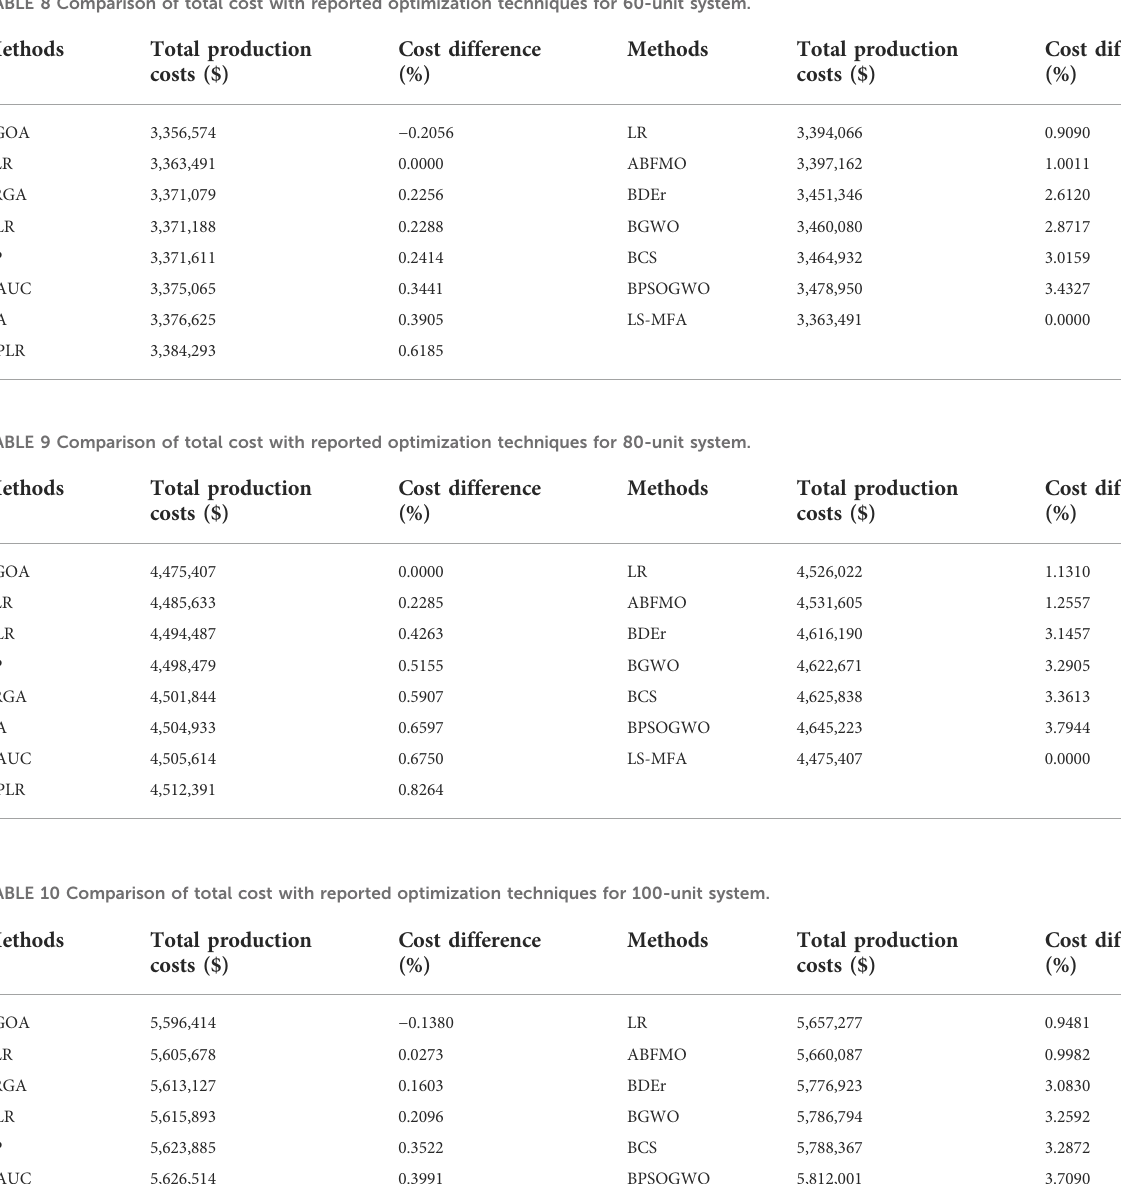
TABLE 8 Comparison of total cost with reported optimization techniques for 60-unit system.